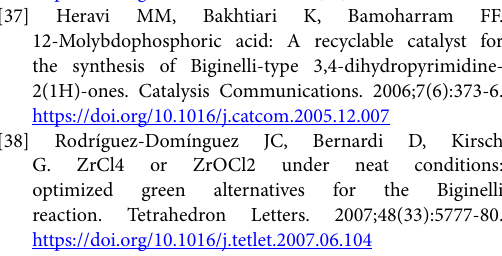
12-Molybdophosphoric acid: A recyclable catalyst